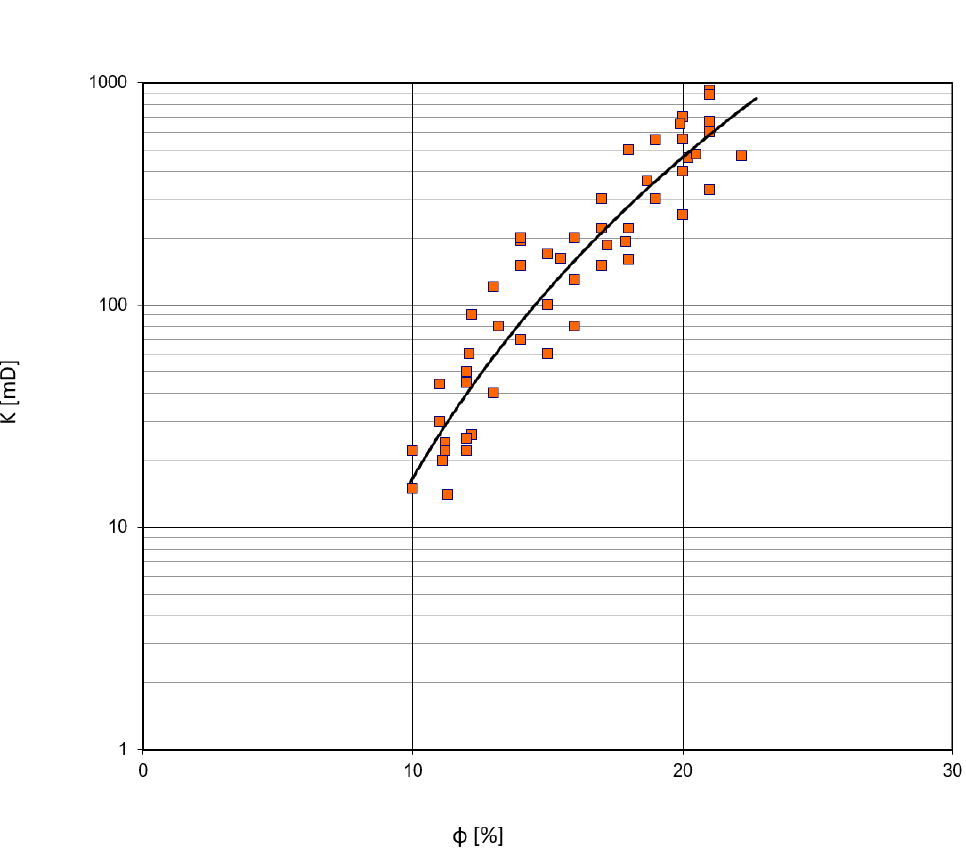
Figure 4. Porosity–permeability relationship.